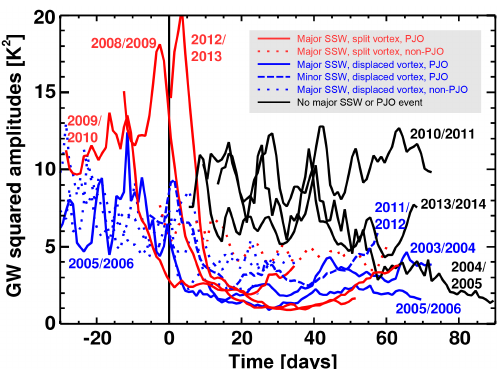
Figure 4. Gravity wave squared amplitudes in K 2 for the winters 2001/2002–2013/2014 averaged over the latitude band 60–80 ◦ N and the altitude range 30–40km. Values for vertical averaging were taken from Fig. 3. The different winters are grouped into major SSW with split vortex and PJO event (red solid), major SSW with split vortex but without PJO event (red dotted), major SSW with dis- placed vortex and PJO event (blue solid), minor SSW with displaced vortex and PJO event (blue dashed), major SSW with displaced vor- tex but without PJO event (blue dotted), and winters without major SSW or PJO event (black solid). For winters without major SSW or PJO event, the time scale on the x axis is given in “days of the year” with 1 January 00:00UT as time = 0. For the winter 2011/2012 time = 0 refers to 15 January 2012. For all other winters, time = 0 refers to the time of the central date of the major SSW. For winters with PJO event and for winters without major SSW or PJO event, the curves are labeled with the respective